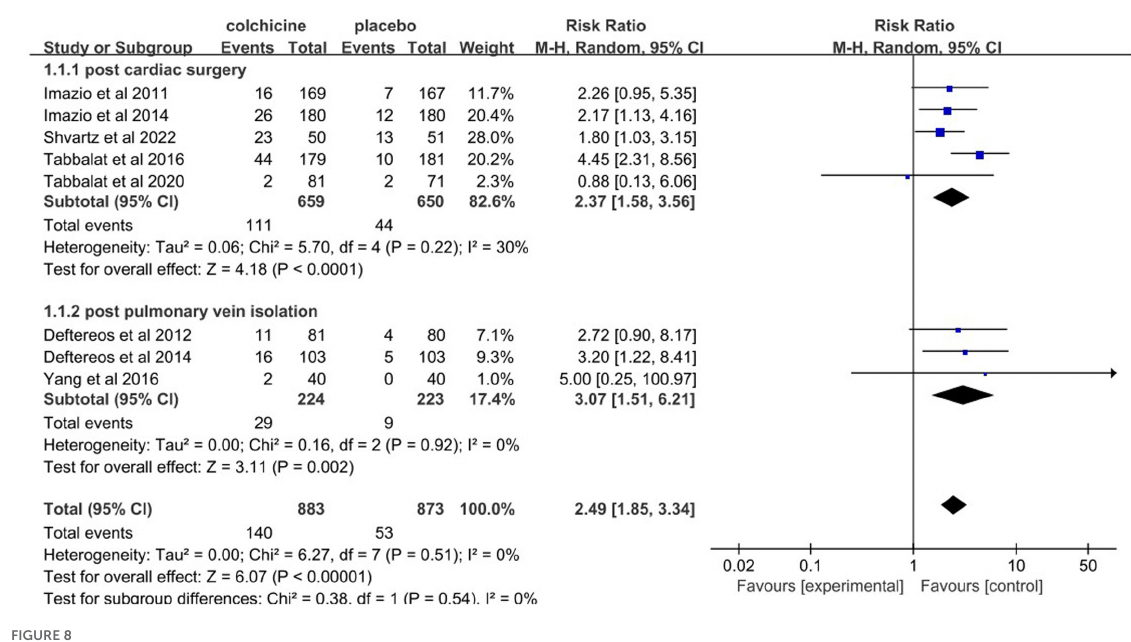
FIGURE8 Forest plot shows gastrointestinal adverse effects.